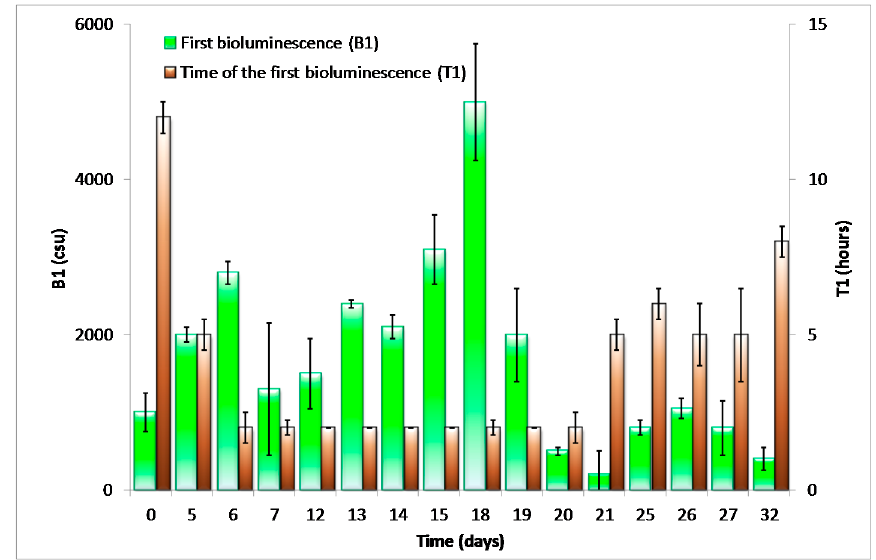
Figure 5. Variability of intensities of the first bioluminescence maxima (B1) and times of their appearance (T1) of the optical fiber elements with P. putida TVA8 encapsulated in silica hydrogel induced repeatedly with toluene (26.5 mg/L). Average ± standard deviations of two reproduced experiments are shown. The same tapered optical element was used in both experiments.